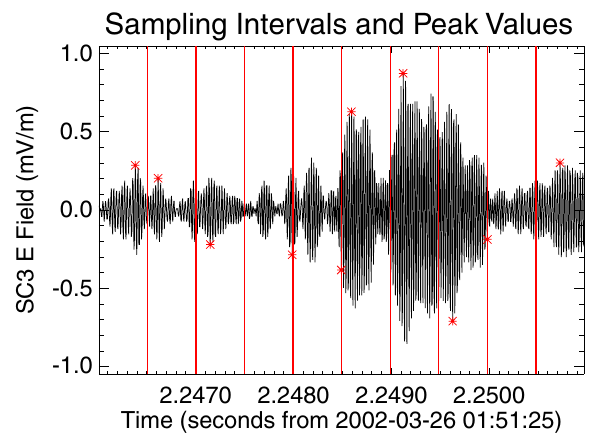
Fig. 2. An example of a typical WBD electric field waveform from 26 March 2002. The vertical lines divide the waveform into 10 seg- ments, which were used to determine the peak electric field values for Figs. 3 and 4. The asterisks mark the peak electric field value in each segment. The amplitudes in this figure have not been corrected for the antenna angle to the magnetic